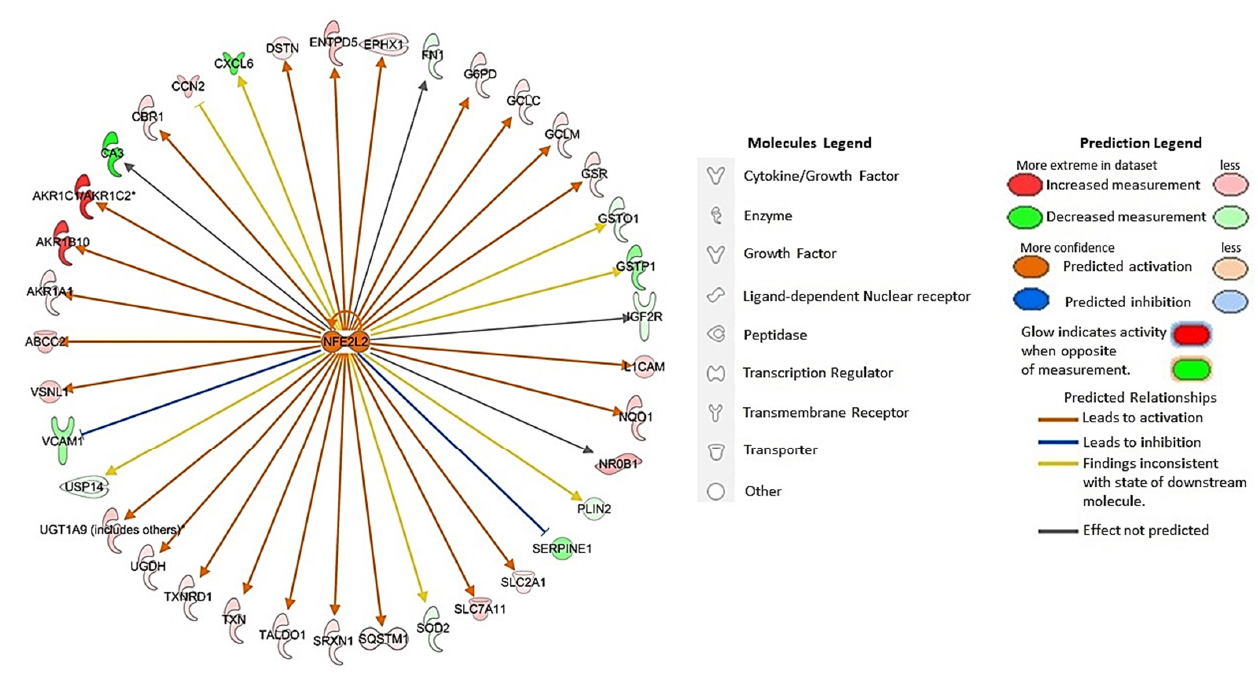
Figure 4. IPA upstream analysis network predicting the activation of NRF2 (NFE2L2). Proteins that